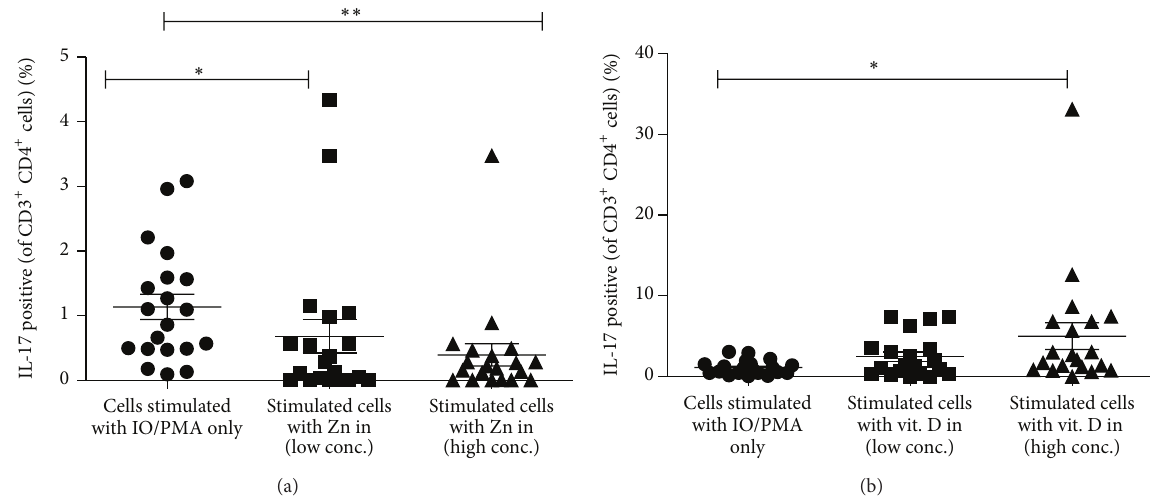
Figure 4: Peripheral blood mononuclear cells were stimulated with Phorbol 12-myristate 13-acetate and ionomycin in the presence or in the absence of Zn and Vit. D and stained and analyzed as described in the legend of Figure 3. Inhibition of IL-17 production by Zn in low (3 𝜇 mol/L) and high (30 𝜇 mol/L) concentrations (a). Significant increase in IL-17+ cells in the presence of high concentration (500 ng/mL) of vitamin D3 (b). ∗ indicates 𝑃 < 0.05 and ∗∗ indicates 𝑃 < 0.01 .